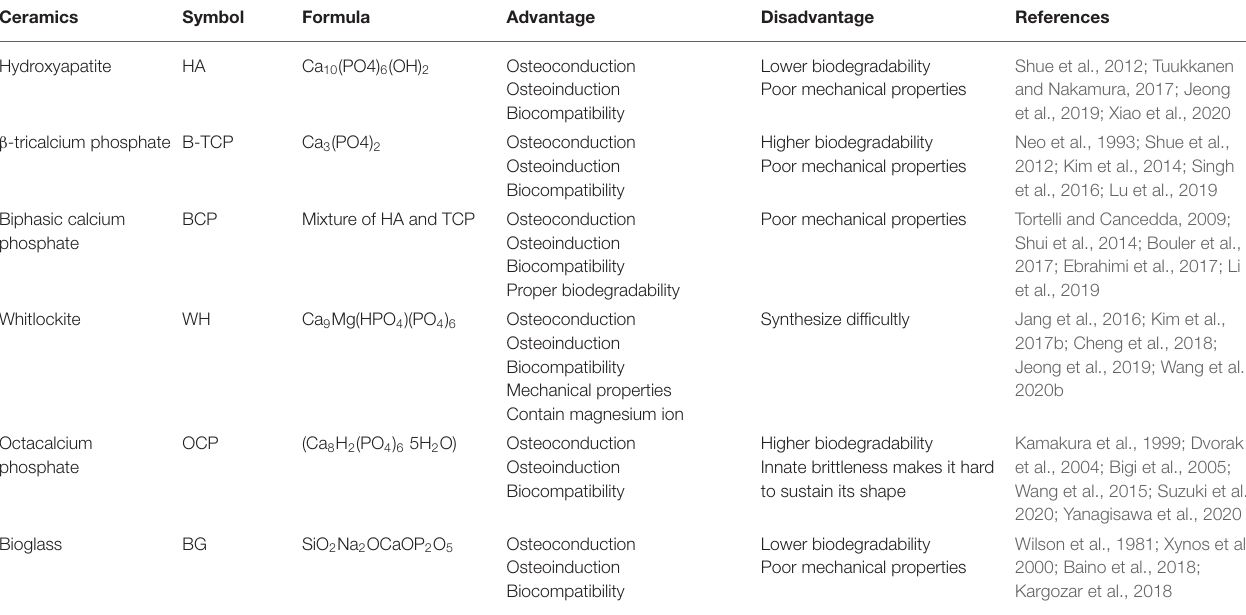
TABLE 1 | Characteristics of various ceramics biomaterials used in BTE.